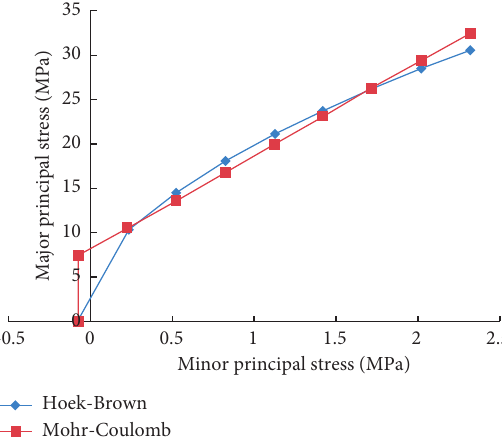
Figure 15: Normal stress-shear stress curve.